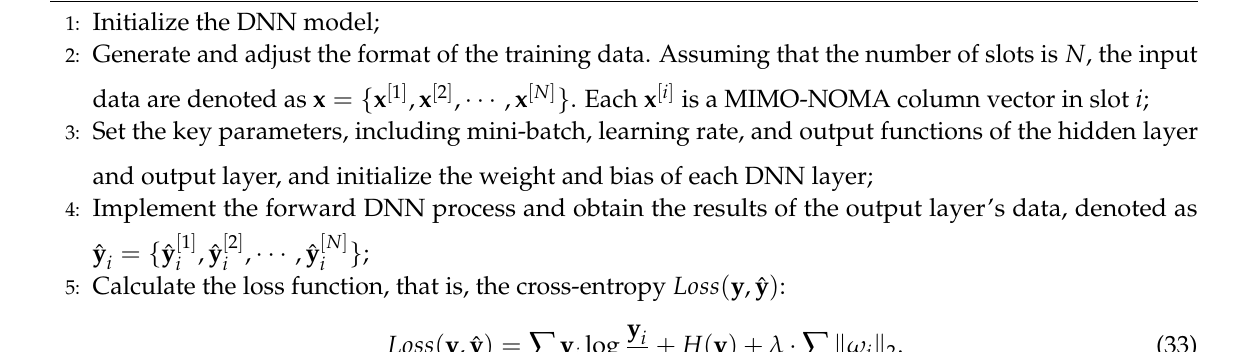
Algorithm 1 MIMO-NOMA Based on the DL Training